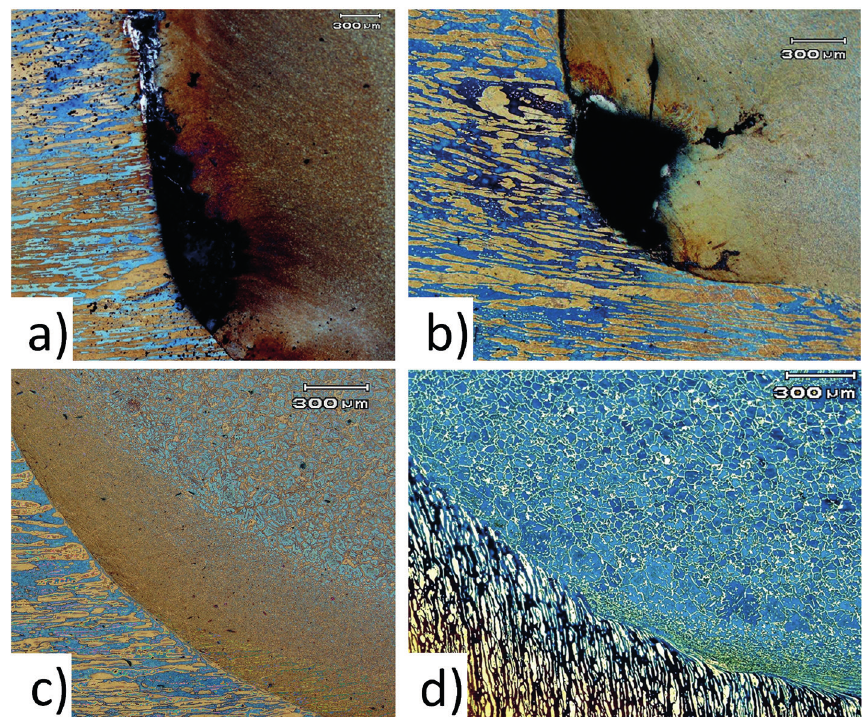
Figure 5: Micrographs. a) The force 5 kN show incomplete. b) The force 10 kN show incomplete filling too. c) The force 18 kN show insufficient mixing. d) The force 25 kN show complete